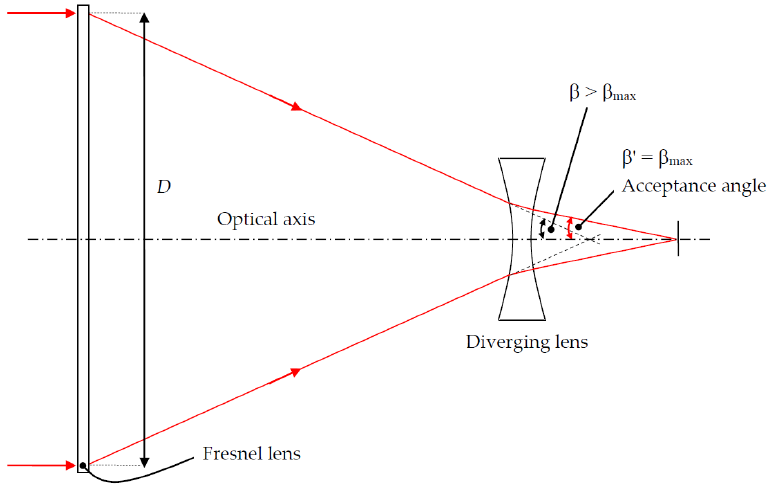
Figure 2. Scheme showing a concentration system (Fresnel lens) and a diverging lens to satisfy the acceptance angle of a possible conducting optical cable (not shown in the